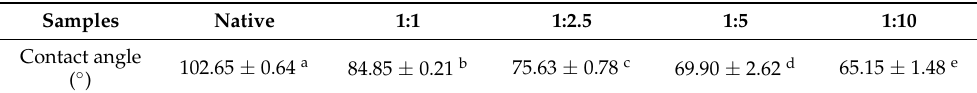
Table 1. Contact angle ( θ ) of native quercetin and quercetin particles formed by antisolvent precipitation with various antisolvent ratios (1:1, 1:2.5, 1:5, 1:10). Samples Native 1:1 Contact angle ( ◦